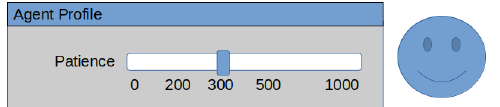
Figure 4. A partial view of the Graphical User Interface (GUI) used to de- termine how the agent reacts to its own